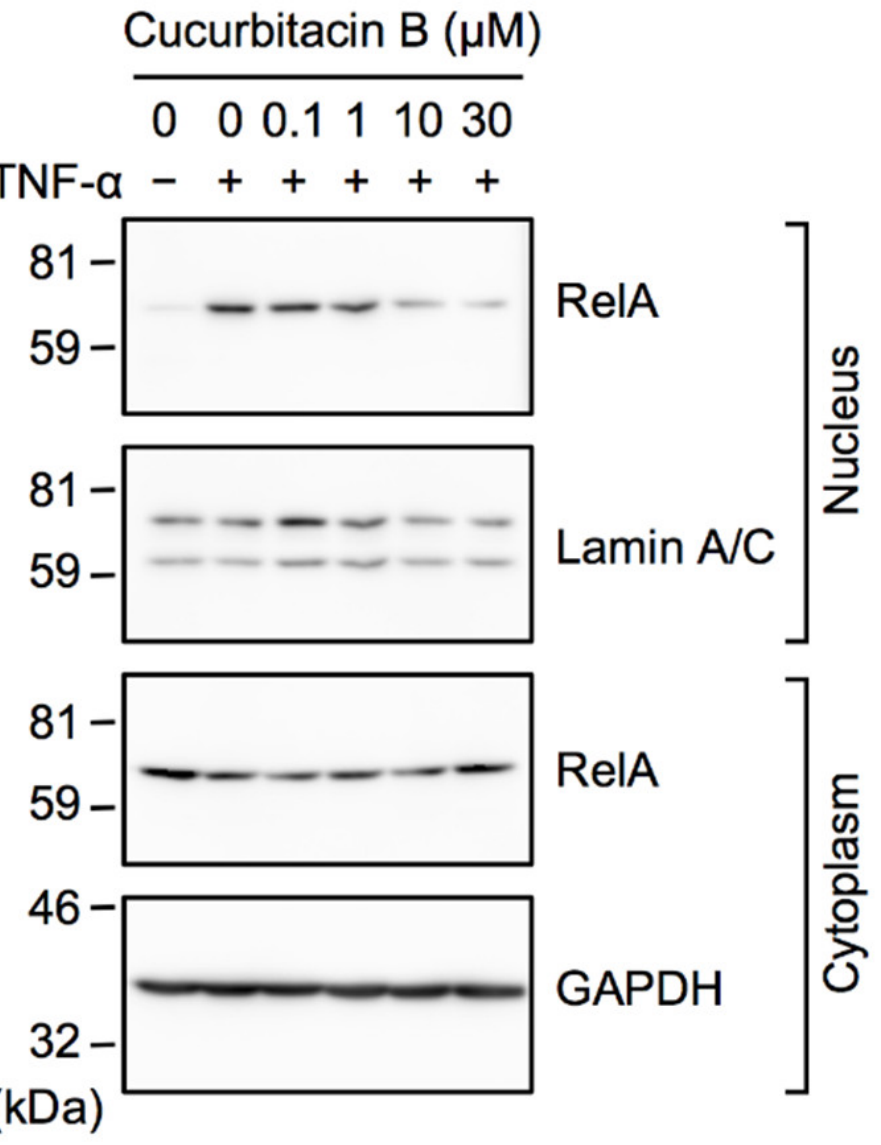
Figure 3. Cucurbitacin B inhibited the TNF- α -induced nuclear translocation of RelA. A549 cells were pretreated with or without cucurbitacin B for 1 h and were then treated with (+) or without ( − ) TNF- α (2.5 ng/mL) for 30 min in the presence or absence of cucurbitacin B at the indicated final concentrations, followed by the preparation of nuclear and cytoplasmic fractions. Western blots are representative of two independent experiments.